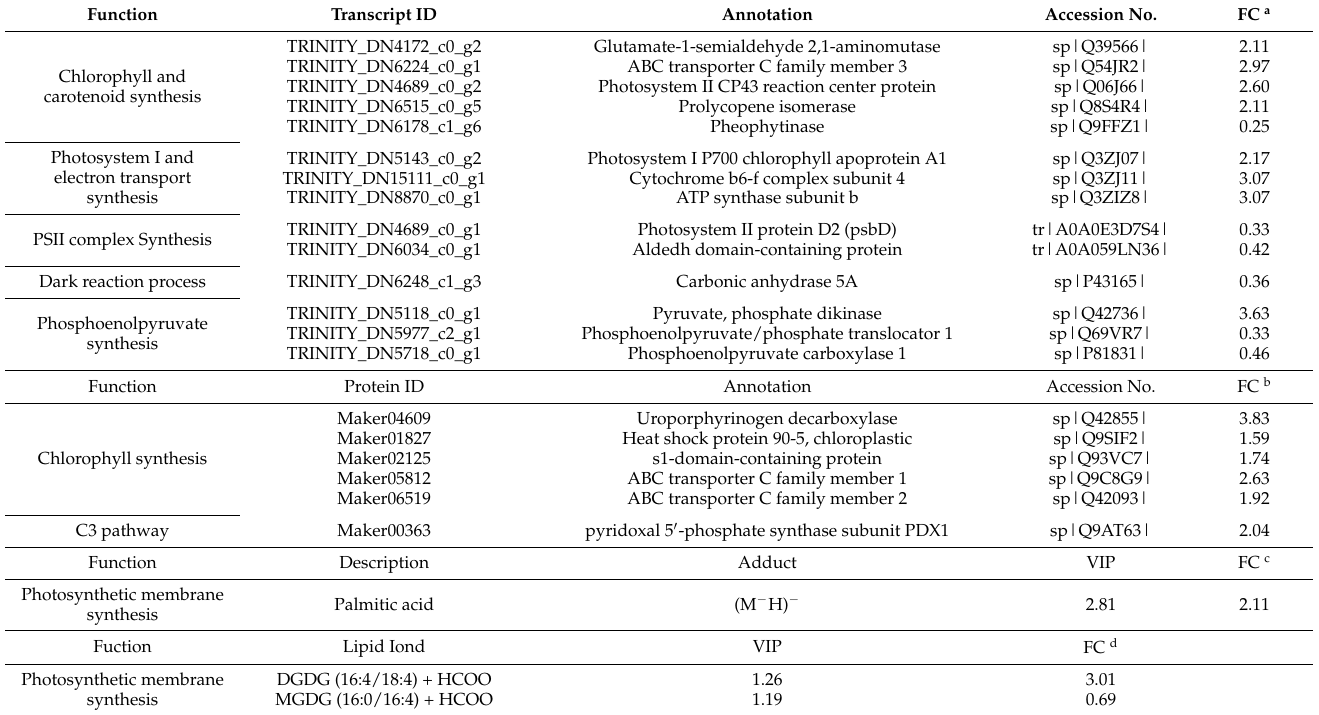
Table 1. Fluctuation of molecules in U. prolifera on photosynthesis after 12 h treatment with high